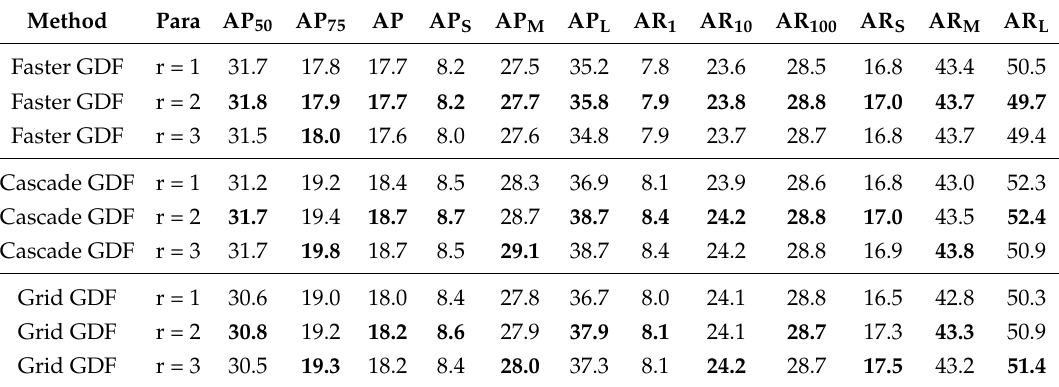
Figure 6. Visualization of L f and L g features in the proposed GDF-Net. The images in row 1–5 show the visualization results of five layer L f or L g based on Faster GDF, respectively. The last row presents object detection results of three images (every two pictures are results with the same input image) from VisDrone dataset, where ( a , c , e ) are tested by Faster R-CNN, and ( b , d , f ) are detected from Faster GDF, respectively. Table 4. Sensitivity analysis on the VisDrone dataset. We analyze the effects of r setting in Section 3.3 with multiple algorithms, and all experiments are performed with